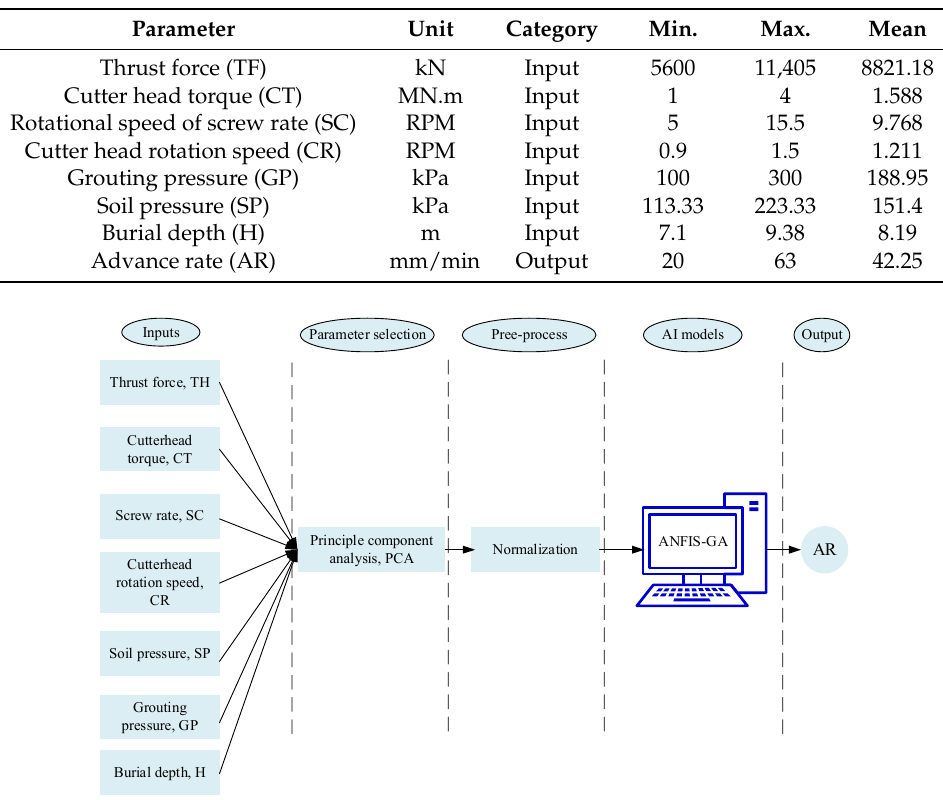
Figure 5. Schematic steps for predicting tunnel boring machines (TBM) performance.